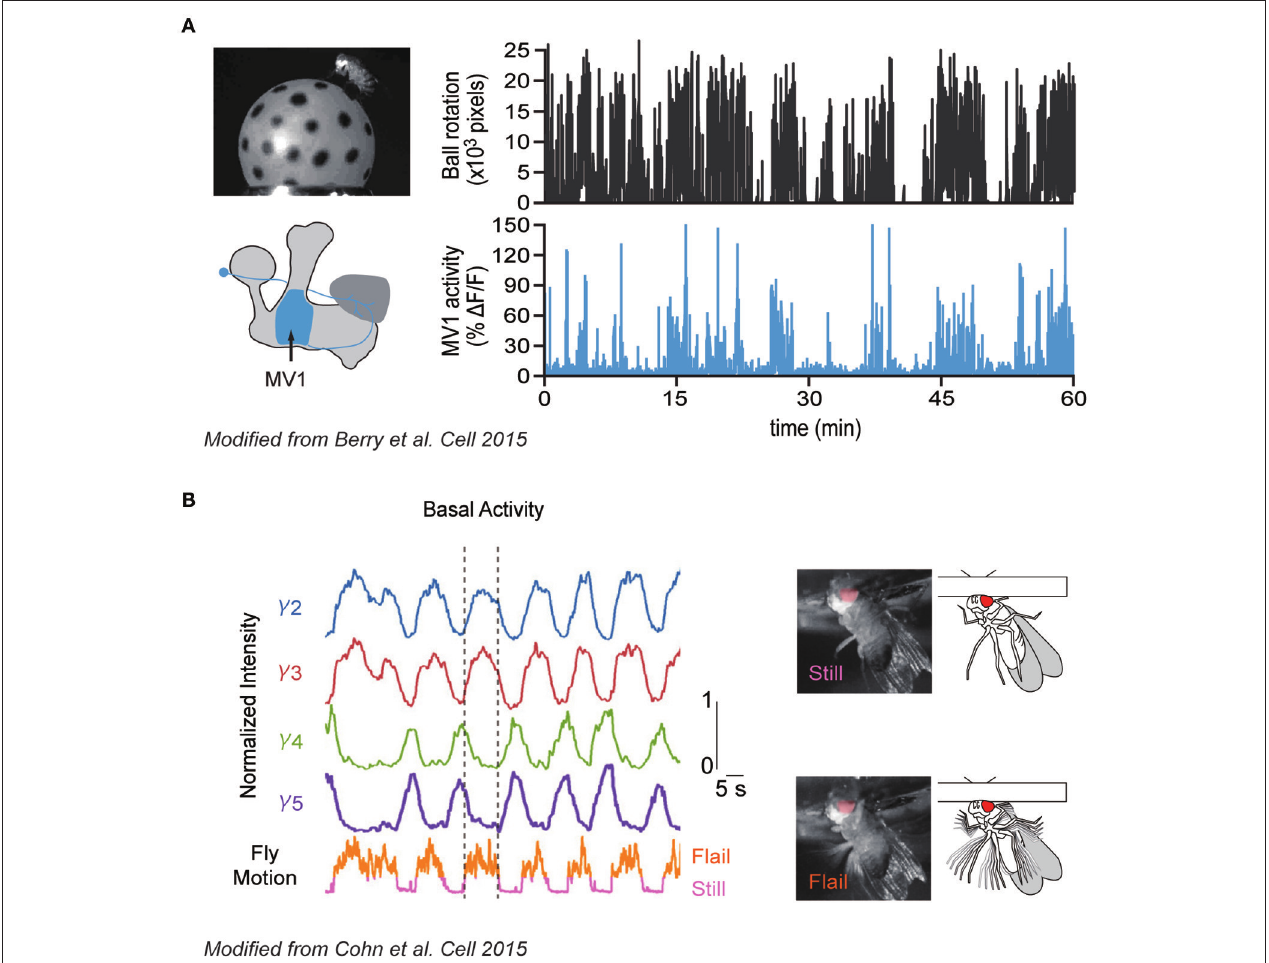
FIGURE 1 | Correlative spontaneous DAN activity with the locomotive state. (A) Correlation between locomotive state and DAN activity. Left: Walking activity of a fly was monitored by observing the rotation of the ball during the calcium imaging of defined DAN types (MV1). Right: Walking activity of a fly (top) and calcium responses of MV1 (bottom). MV1 shows strong activity during walking bout. (B) Correlative and anti-correlative DAN activities with flailing. Left: Calcium responses of different DAN types innervating different MB compartments ( γ 2- γ 5, top), and locomotive activity of a head-fixed fly (bottom). Dashed lines delineate the start and cessation of a single flailing bout. Right: Two activity states of a fly during imaging (still and flail). Modified from Berry et al. (2015) and Cohn et al. (2015) with a permission.